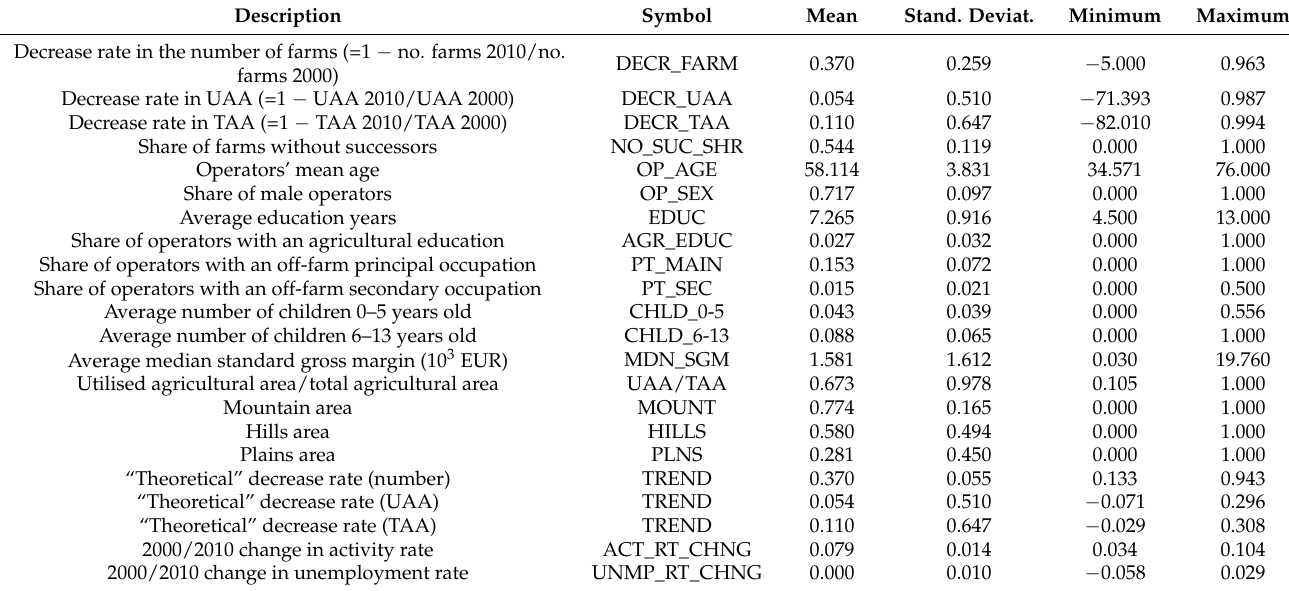
Table A1. Descriptive statistics using the all farms